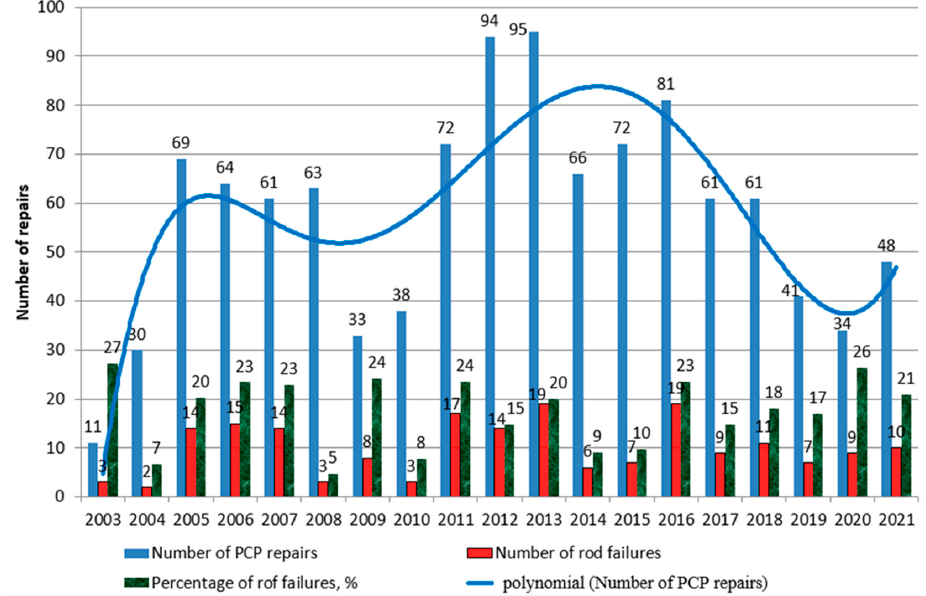
Figure 1. Distribution of rod failures by year.